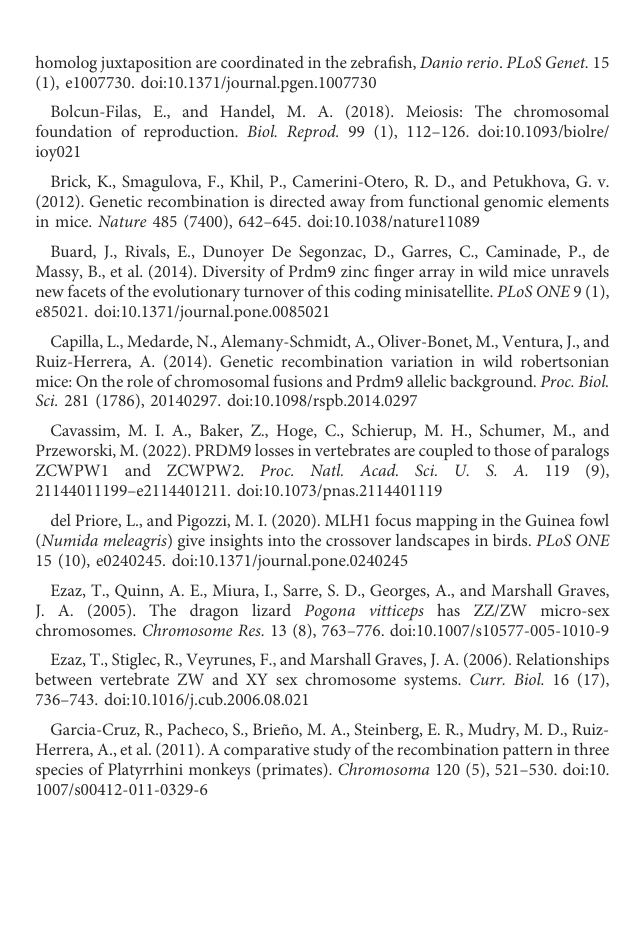
SUPPLEMENTARY FIGURE 1: SynapsisdynamicsduringprophaseI.Spermatocytespreadslabelledwith antibodies against SYCP3 (green) and SYCP1 (red), counterstaining the